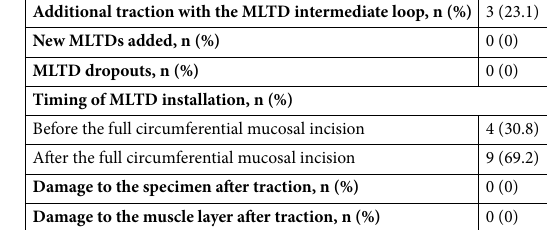
Table 3. Treatment outcomes of the MLTD group. MLTD multi-loop traction device.